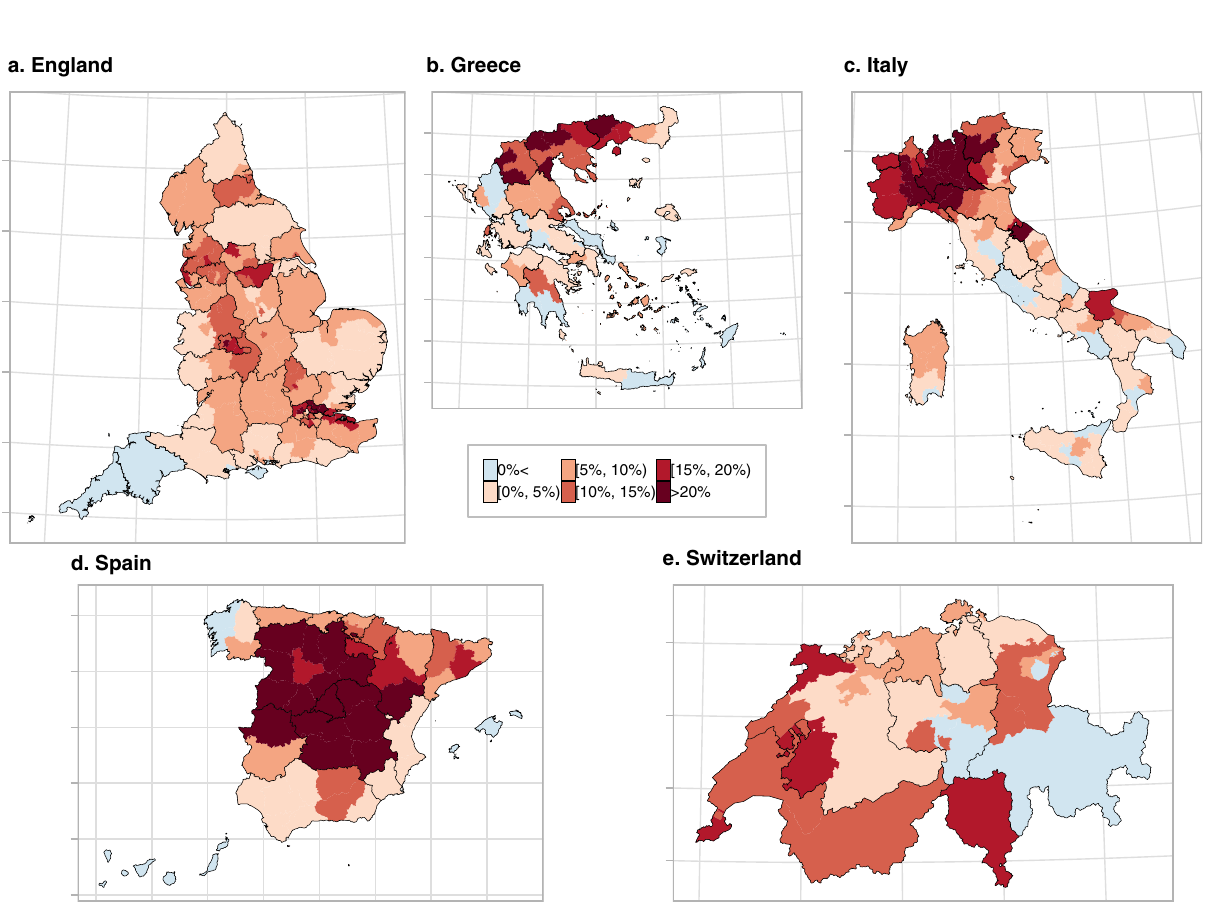
Fig. 2 Median relative excess deaths (%) by NUTS3 region in 2020. a Median relative excess deaths (%) in England. b Median relative excess deaths (%) in Greece. c Median relative excess deaths (%) in Italy. d Median relative excess deaths (%) in Spain and e median relative excess deaths (%) in Switzerland in categories. Areas in blue indicate areas that observed less deaths than expected had the pandemic not occurred, whereas the different shades of red indicate the higher relative excess mortality. The black solid lines correspond to the NUTS2 region